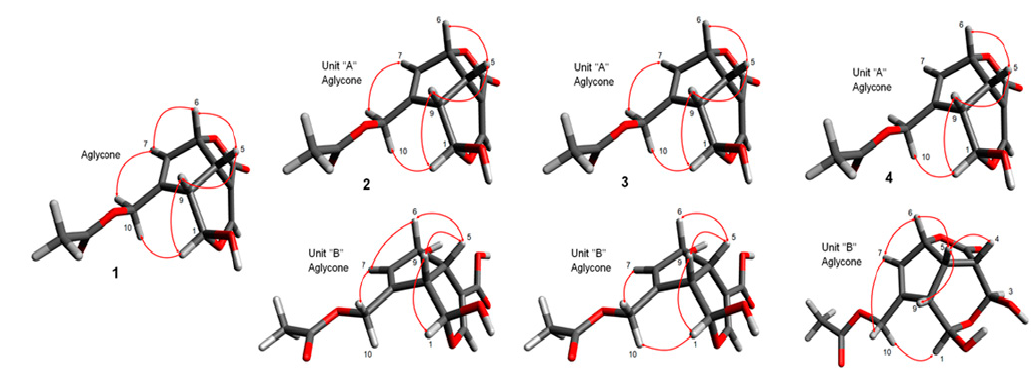
Figure 2. COSY and HMBC correlations of 1 – 4 .